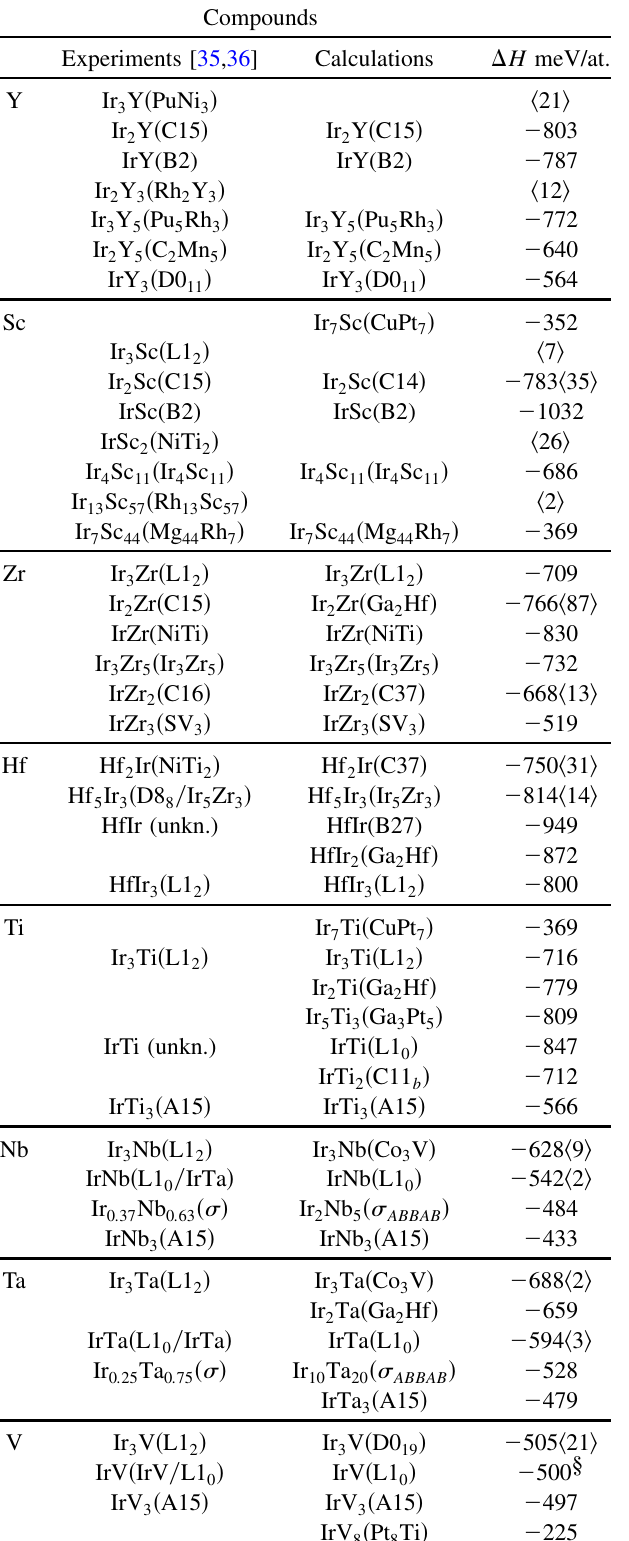
TABLE III. Compounds in Iridium binary alloys. The super- script ‘‘ x ’’ denotes relaxation of one prototype into another and a ‘‘ y ’’ denotes new prototypes described in Table VII. The other symbols are as in Table